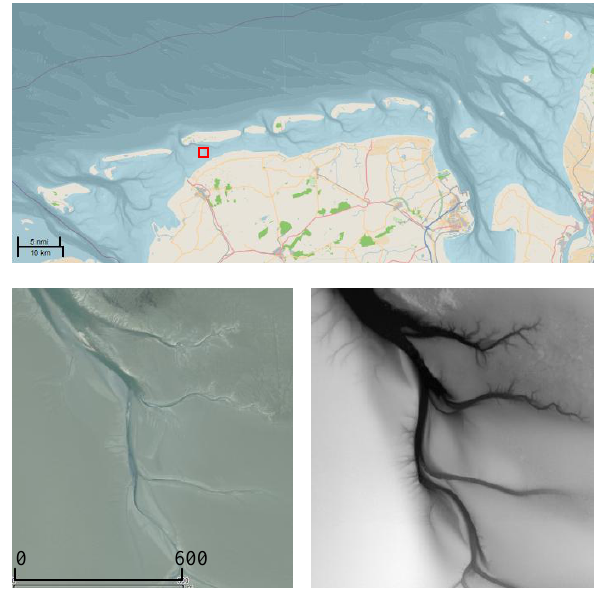
Figure 1. The approximate test site location outlined in red in a general map (top), an orthophoto of the scene (bottom left), and the lidar DTM of 2012 (bottom right)